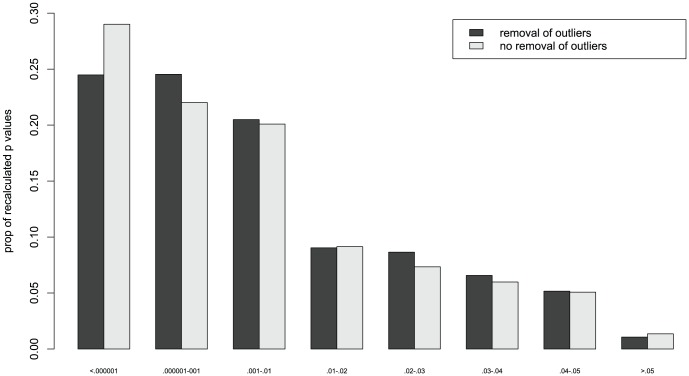
Distribution of p values reported as being significant (at p<.05) in 92 papers from which outliers were removed (N = 1781; in black) and in 61 papers that did not report any removal of outliers (N = 886; in grey).